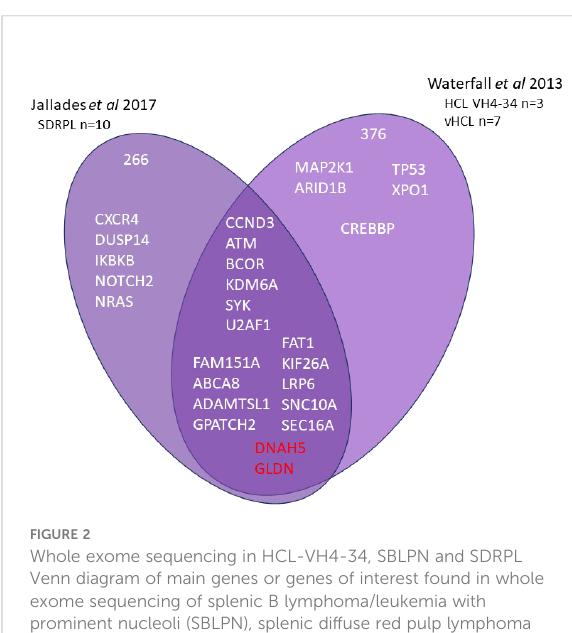
FIGURE 1 Whole exome sequencing in HCL. Venn diagram of main genes or genes of interest found in whole exome sequencing of hairy cell leukemia (HCL).